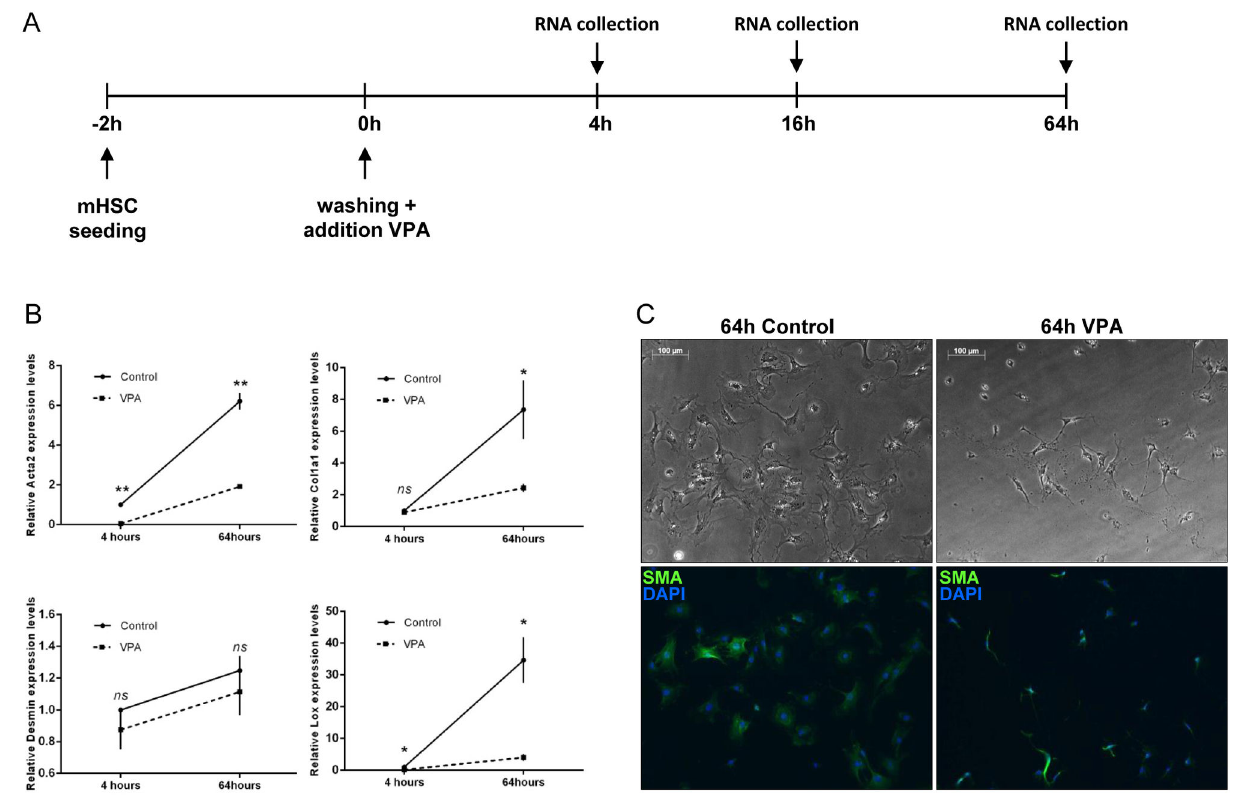
Figure 1. Experimental set-up and sample validation. ( A ) Mouse hepatic stellate cells (HSCs) were isolated from Balb/C CBY jicco mouse livers by Nycodenz gradient. Next, the cells were cultured for 2 hours after which unattached cells and debris were removed by washing. The HSCs were further cultured for 4, 16 and 64 hours in the presence or absence of valproic acid (VPA). ( B ) At the indicated time points, cells were collected for mRNA analysis of HSC activation genes actin, alpha 2 , smooth muscle, aorta (Acta2), lysyl oxidase (Lox), collagen, type I , alpha 1 (Col1a1) and Desmin. ( C ) In addition, immunocytochemistry for α-smooth muscle actin (SMA) was performed on cells cultured for 64 hours. Staining was visualized using a secondary Alexa-488 antibody and nuclei were stained with 4’,6-Diamidino-2-phenylindole (DAPI). Experiments were repeated at least 3 times. In the graphs, the results are displayed as means ± SEM. ns = not significant p ≥ 0.05, * p < 0.05, ** p < 0.01. doi: